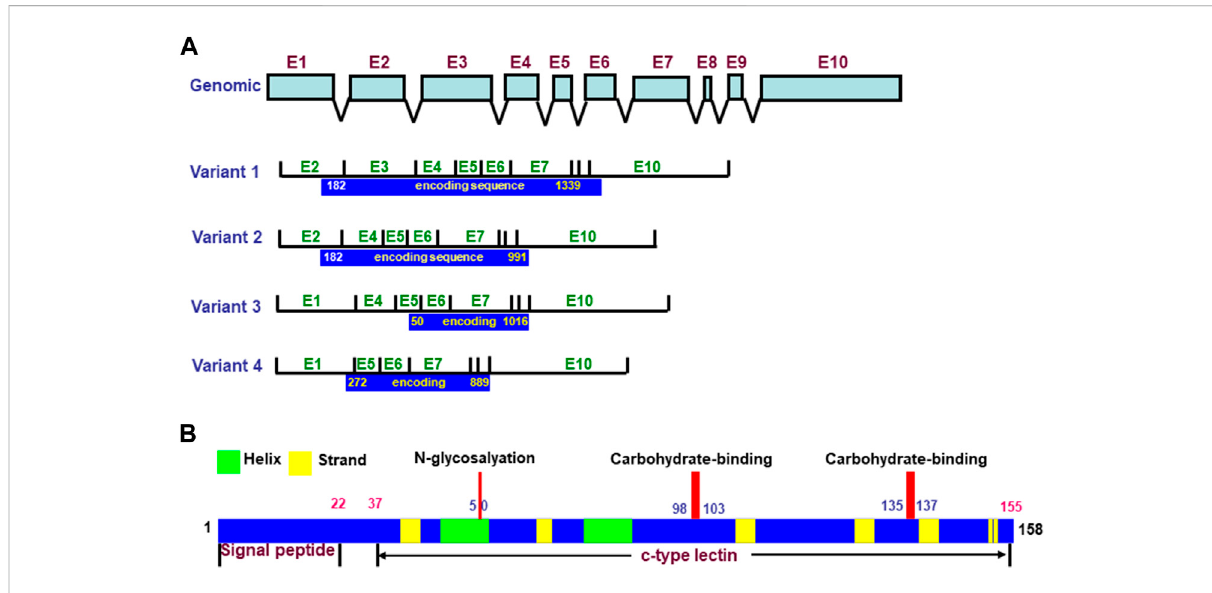
FIGURE 1 Structures of REG4 gene and protein. The REG4 gene has 10 exons and is alternatively spliced into four variants with different open reading frames (A) . The encoding protein of REG4 variant one produces a 158aa protein with signal peptide and c-type lectin domain (B)